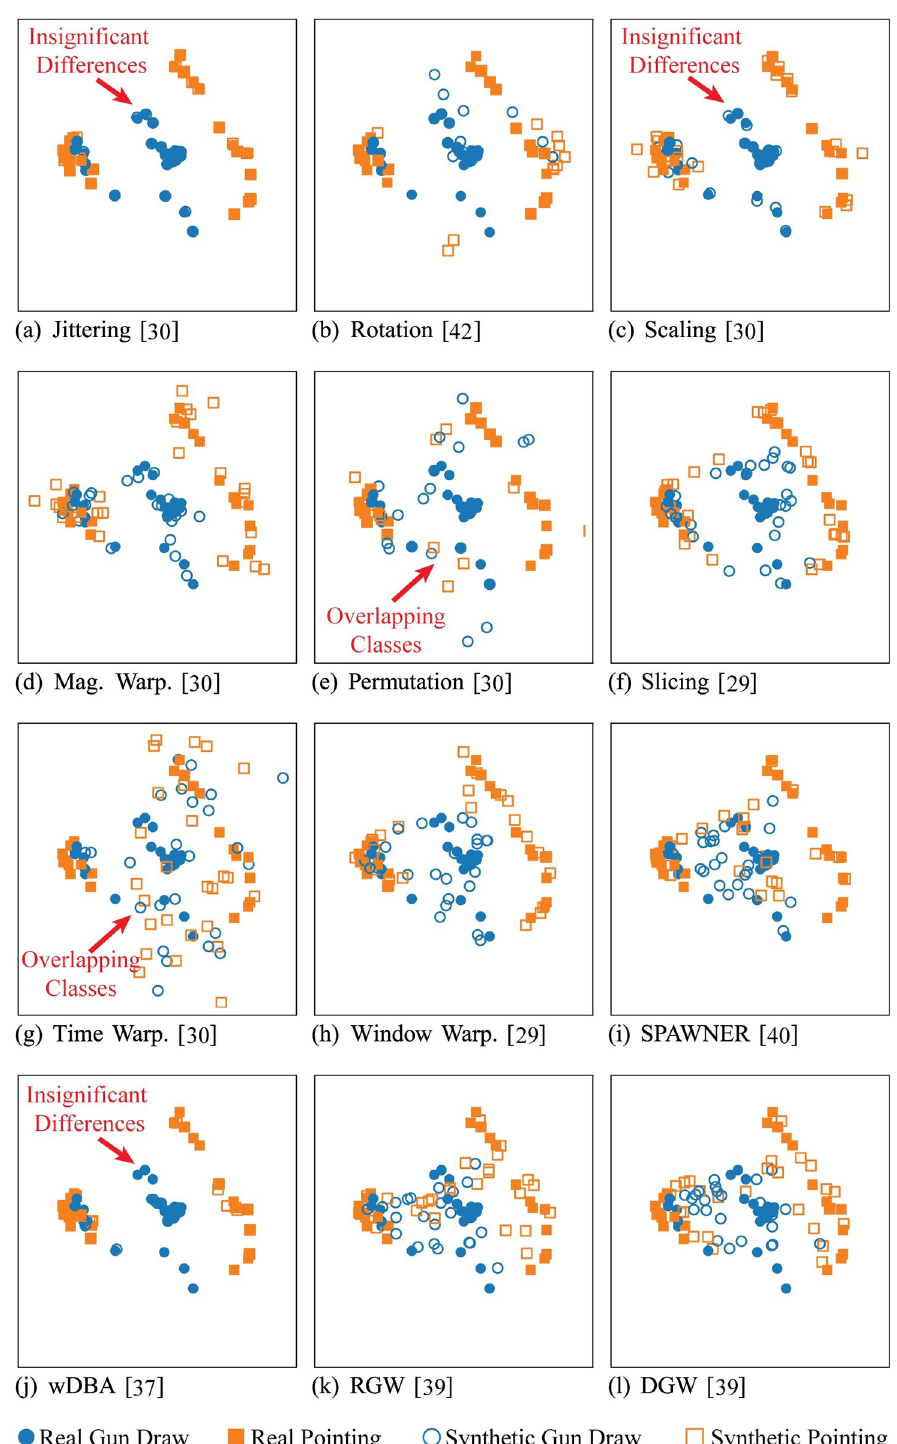
Fig 4. Visualization of the GunPoint dataset using PCA and the compared augmentation methods. The solid shapes are the original time series, the hollow shapes are the generated time series, and the colors indicate different